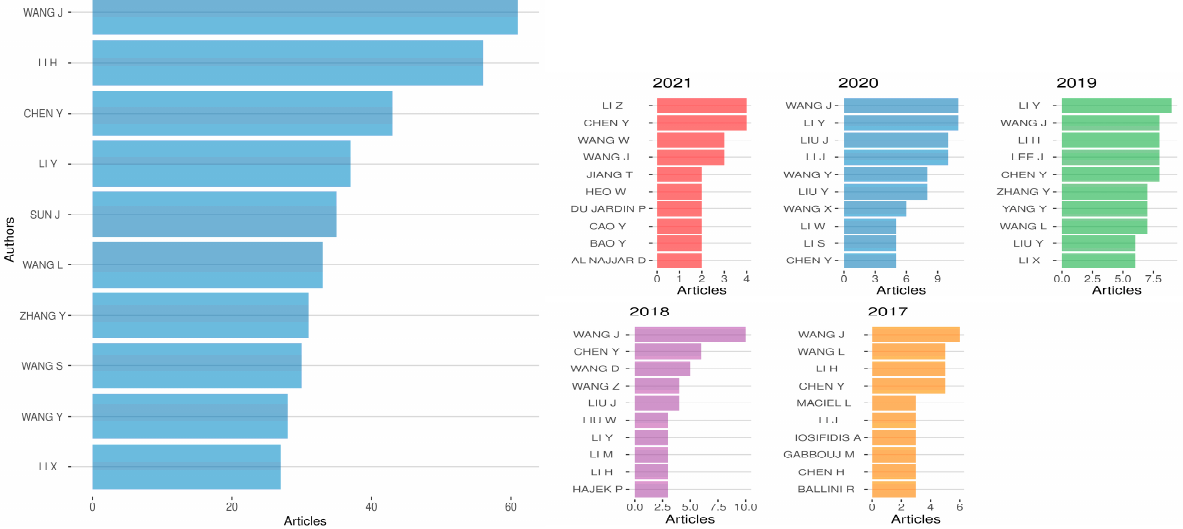
Figure 5. Top authors in terms of production, overall period, and per year.